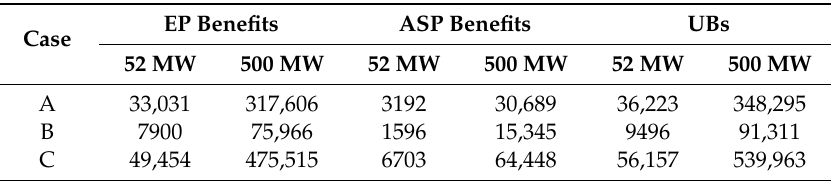
Table 7. Projected Energy Market Price (EP) Benefits, Ancillary Service Price (ASP) Benefits, and Utility Benefits (UBs), 2019–2028 (Unit: Thousands of